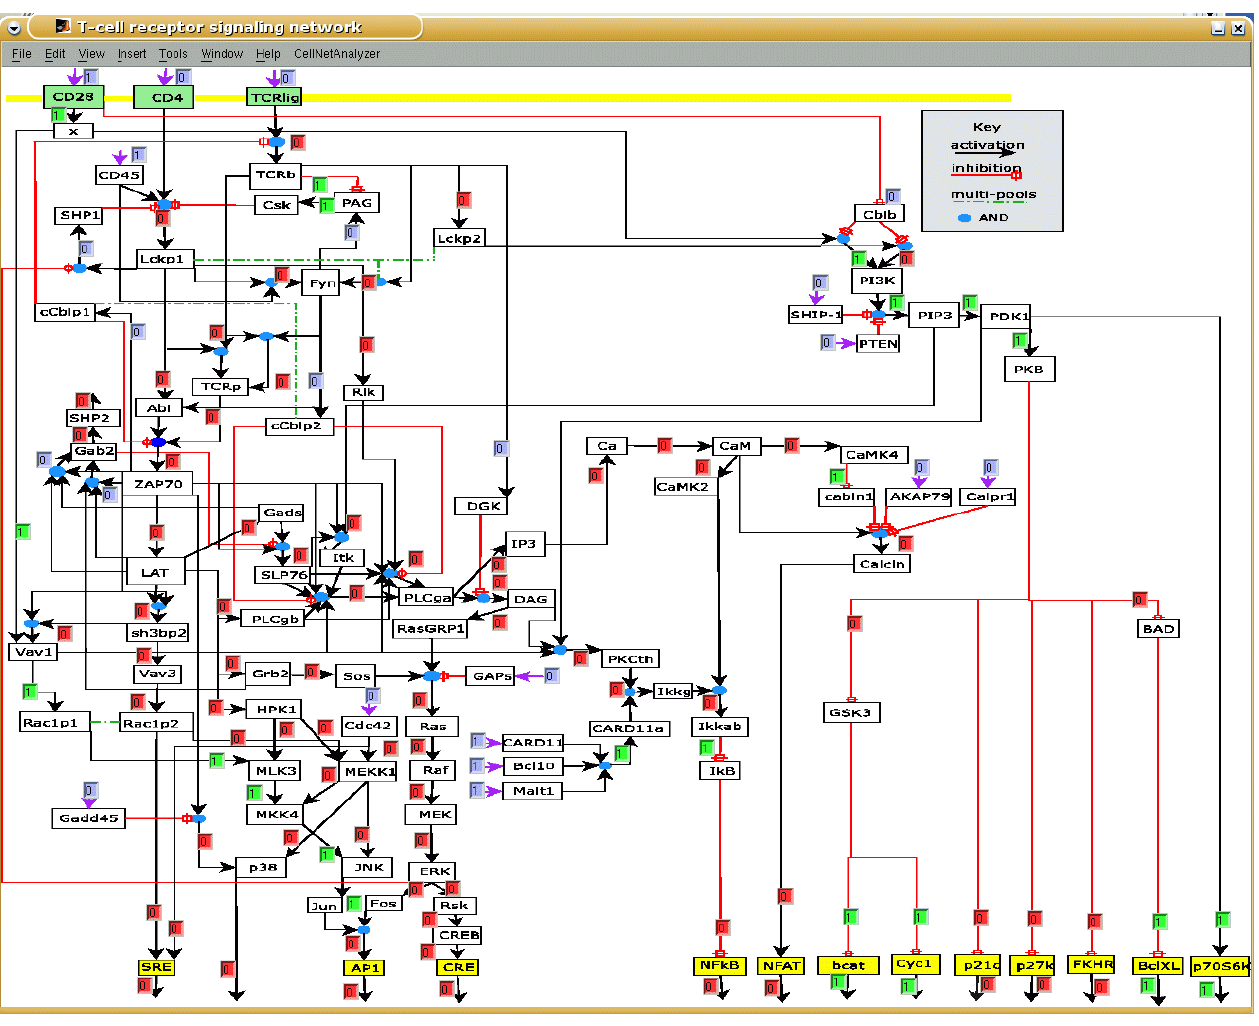
Figure 1. Logical Model of T Cell Activation (Screenshot of CellNetAnalyzer) Each arrow pointing at a species box is a so-called hyperarc representing one possibility to activate that species (see Methods). All the hyperarcs pointing at a particular species box are OR connected. Yellow species boxes denote output elements, while green ones represent (co)receptors. In the shown ‘‘ early-event ’’ scenario, the feedback loops were switched off, and only the input for the costimulatory molecule CD28 is active (scenario in column 2 of Table 1). The resulting logical steady state was then computed. Small text boxes display the signal flows along the hyperarcs (blue boxes: fixed values prior to computation; green boxes: hyperarcs activating a species (signal flow is 1); red boxes: hyperarcs which are not active (signal flow is 0)).